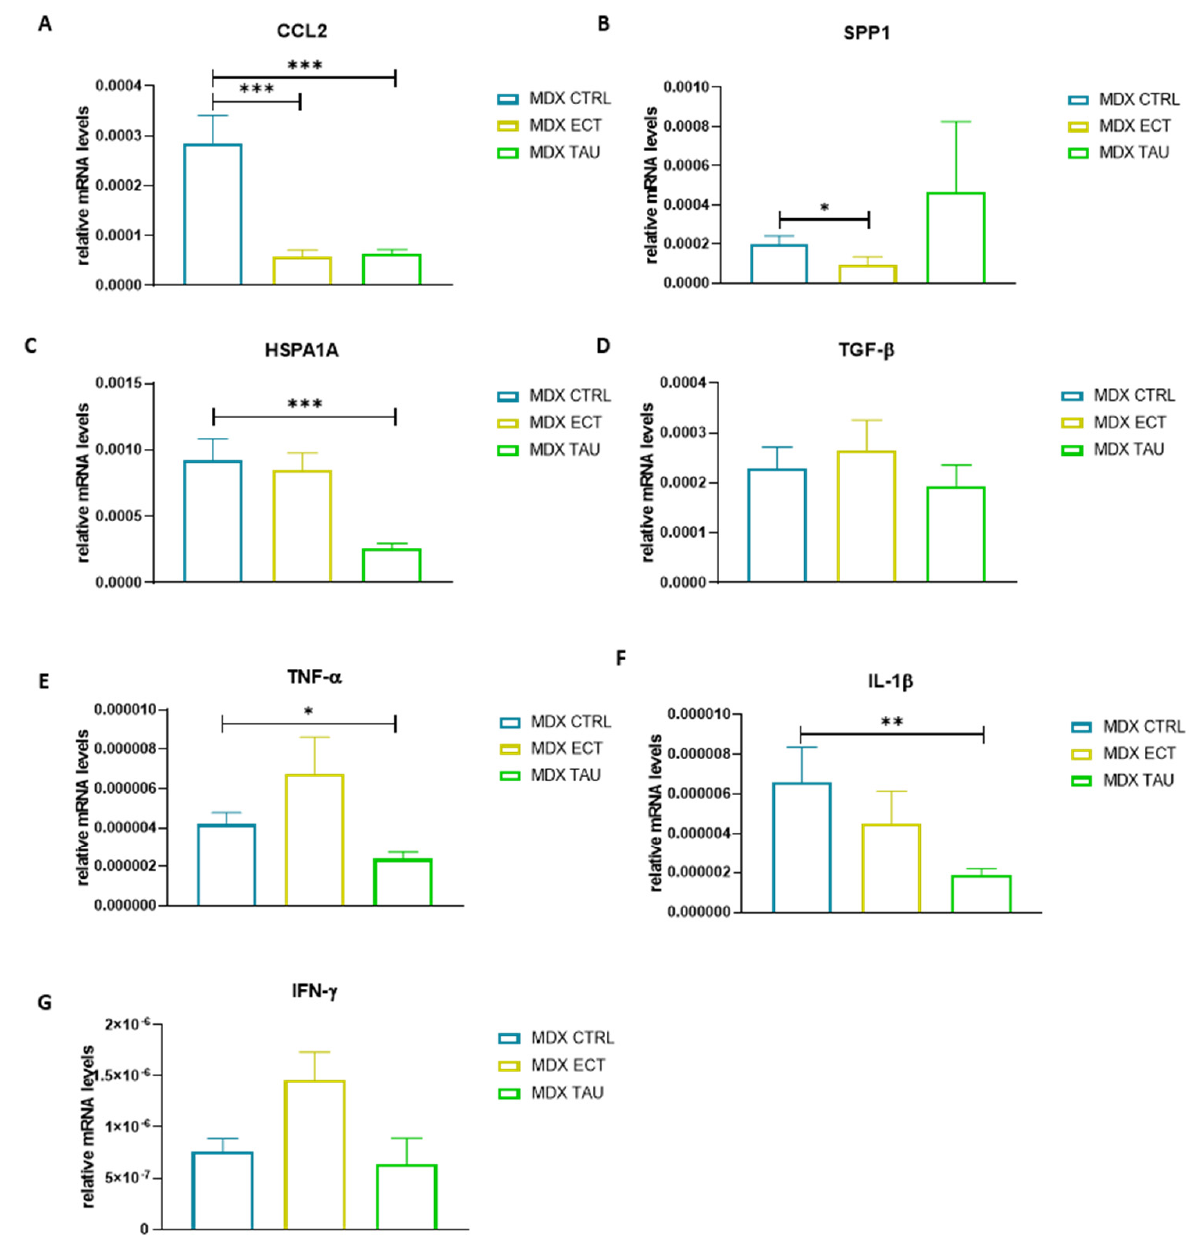
Figure 6. Relative gene expression of inflammatory markers in treated and untreated mdx mice. Graphical representation of mRNA levels of CCL2 ( A ), SPP1 ( B ), HSPA1A ( C ), TGF- β ( D ), TNF- α ( E ), IL-1 β ( F ) and IFN- γ ( G ). Relative gene expression is normalized to the housekeeping gene GAPDH and expressed as 2 −Δ CT , and data are presented as 2 −Δ CT mean ± standard error of the mean (SEM). Data underwent a log-transformation in order to adhere to normality assumptions. A more detailed overview of statistical analysis is provided in Table S3. Statistical analysis was carried out to detect differences between untreated mdx mice and other groups. Significant differences are annotated by * ( p < 0.05), ** ( p < 0.01) and *** ( p < 0.001).